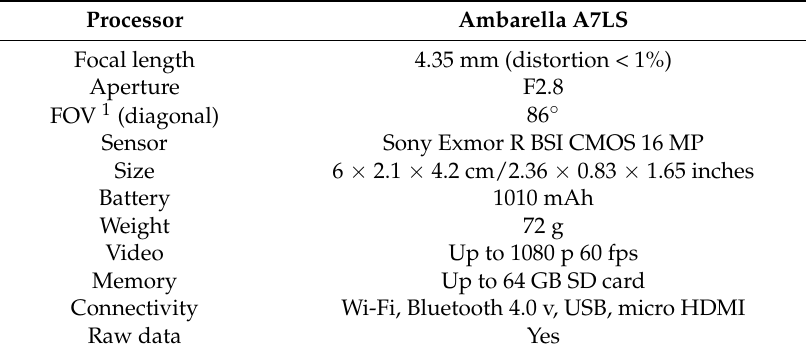
Table 1. Improved Xiaomi Yi camera.